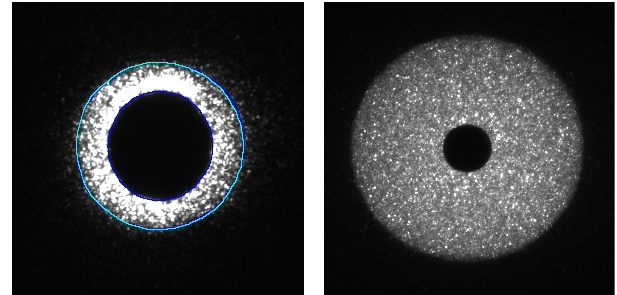
Fig. 2. Images of the solar disk on the field stop of the EM27 spec- trometer (left panel) and the IFS125HR in Karlsruhe (right panel) as recorded by CamTracker. The blue circles in the left image are the outlines, as they are detected and used by the CamTracker pro- gram for maintaining and correcting the precision of the tracking. The field-of-view differs between the EM27 and the IFS125HR.